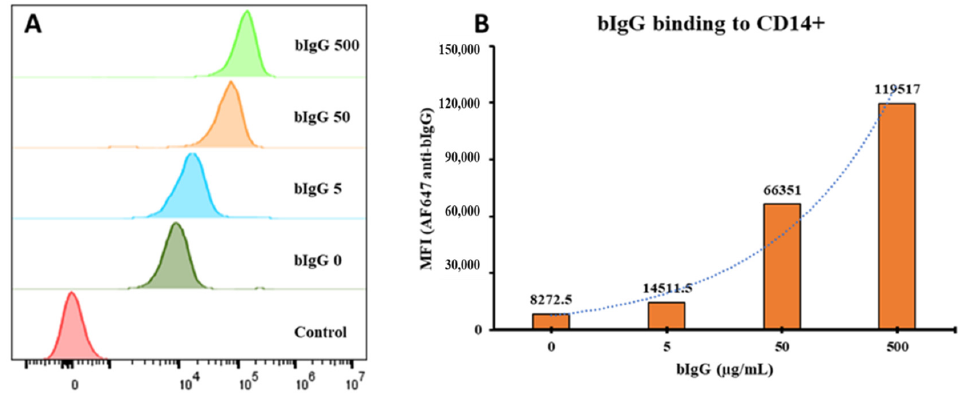
Figure 1. Histogram comparing the mean fluorescence intensity (MFI) of the bovine IgG (bIgG) signal on CD14 + monocytes: Peripheral blood mononuclear cells (PBMCs) were incubated with bIgG (500, 50, 5, or 0 µg/mL) for 20 min ( A ). A dose-dependent increase in the bIgG signal on the CD14 + monocytes was detected with an increase in the concentration of bIgG used ( B